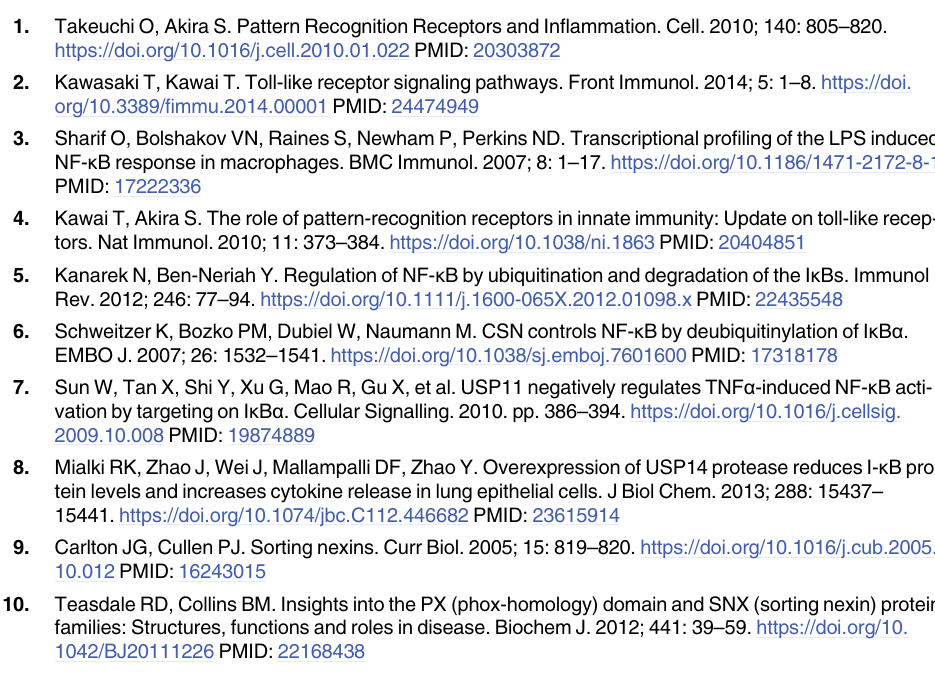
transfected into RAW 264.7 cells. RAW 264.7 cells were incubated for 24h or 48h. The protein level of SNX25 was analyzed by Western blotting. GAPDH was used as a loading control. S2 Fig. LPS time-course of inflammation-related factors. (A-D) RAW 264.7 cells were stim- ulated with LPS (1 μ g/ml) for 10min, 20min, 30min or 1h. The expression of p-ERK, p-p38, p- GAPDH, LaminB1 and α -Tubulin was used as a loading